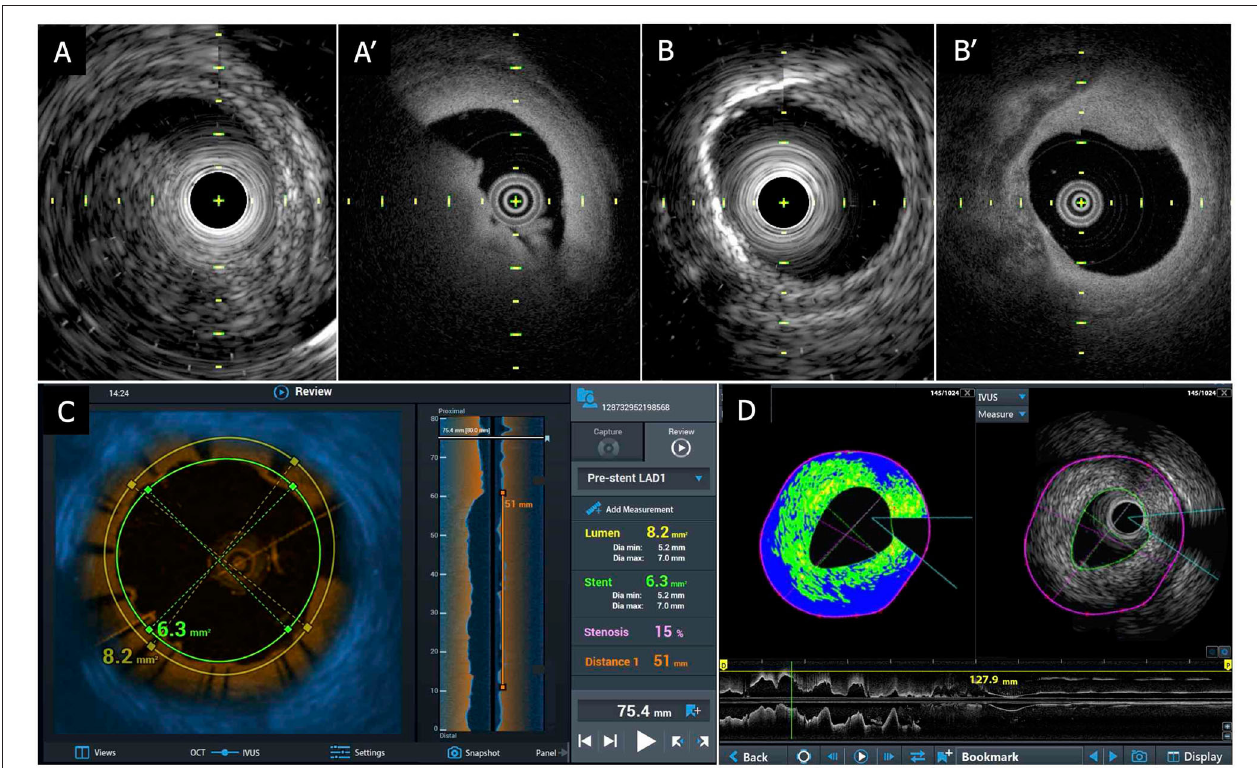
FIGURE 7 | TERUMO hybrid IVUS–OCT catheter system; sample images. (A) Coregistered intracoronary imaging of thrombus in IVUS (A-1) and OCT (A-2) in a cadaver coronary artery. (B) Coregistered intracoronary imaging of calcification in IVUS (B-1) and OCT (B-2) in a cadaver coronary artery. (C) Fusion image of IVUS and OCT. (D) IB-IVUS image with OCT. IVUS, intravascular ultrasound; OCT, optical coherence tomography; IB, integrated